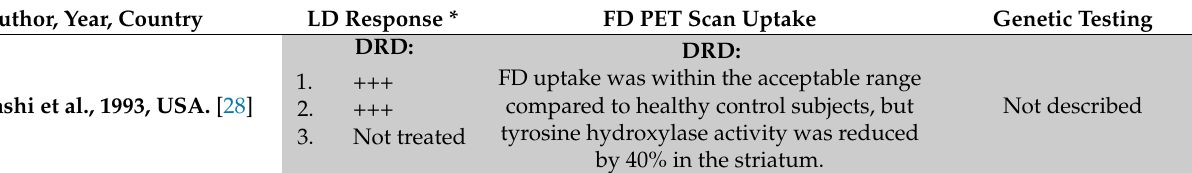
Normal striatal FD uptake compared to EOPD where the structural integrity of the nigrostriatal dopaminergic systems was affected, revealing a decrease in FD